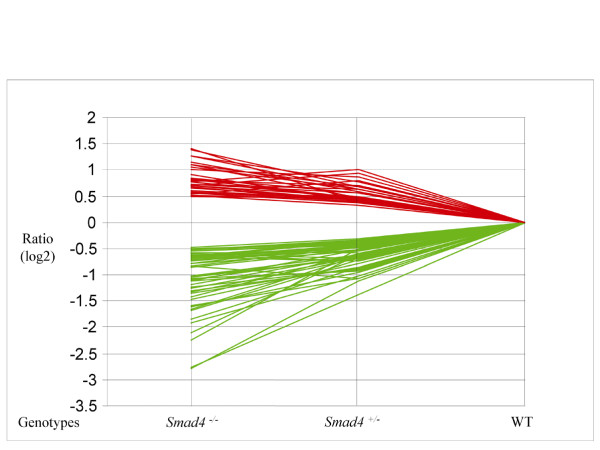
Trend analysis of Smad4 dosage-dependent transcriptional targets. Trend analysis of the 79 genes found to be differentially expressed in both Smad4+/E6sad and Smad4E6sad/E6sad embryonic stem cells. The fold changes are represented as (log2) ratio values and plotted as red and green lines for up- and down-regulated genes, respectively.